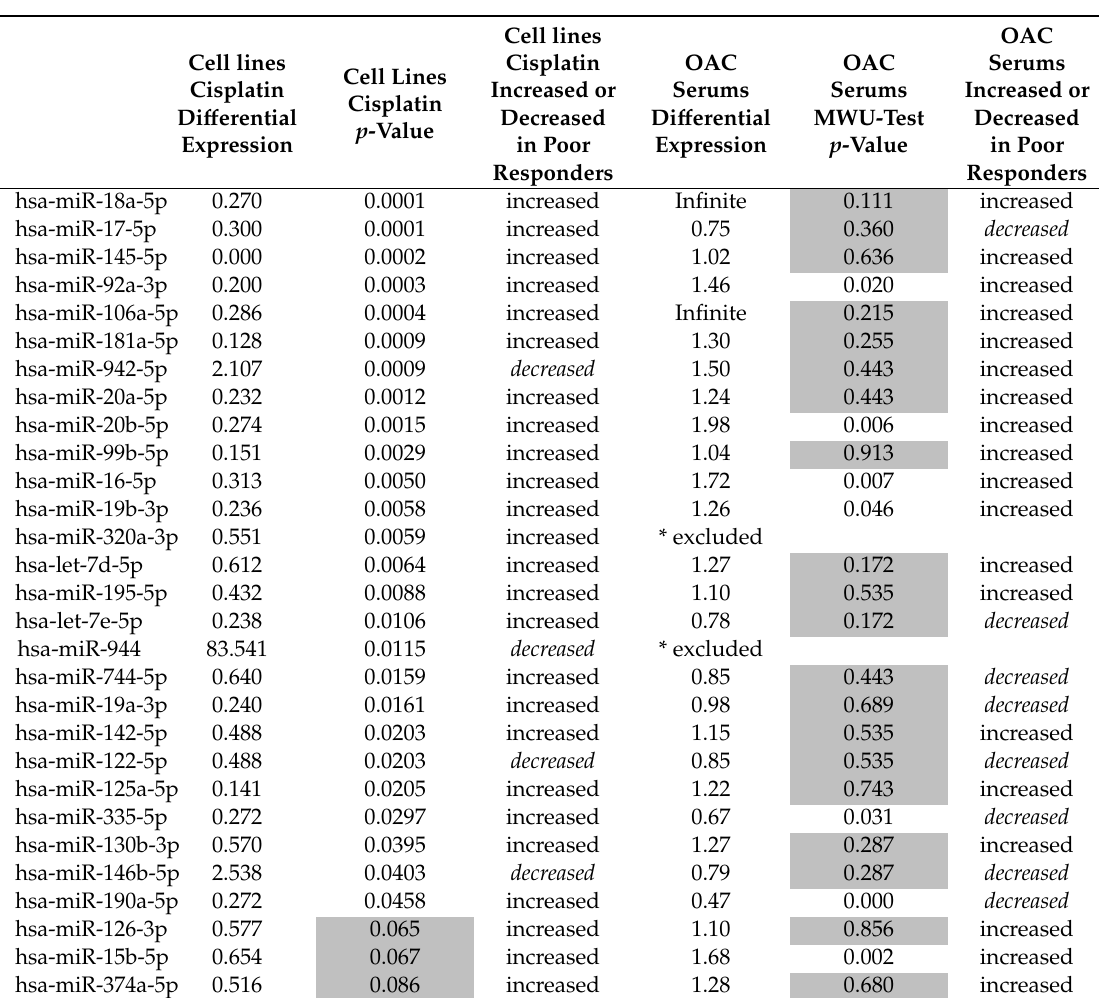
Table 6. Comparison of expression of miRNAs in oesophageal cancer cell lines that were associated with response to Cisplatin treatment, with miRNA levels in pre-treatment serum EVs from patients with oesophageal cancer who responded well vs. poorly to neoadjuvant chemoradiotherapy. Grey highlights p -values >